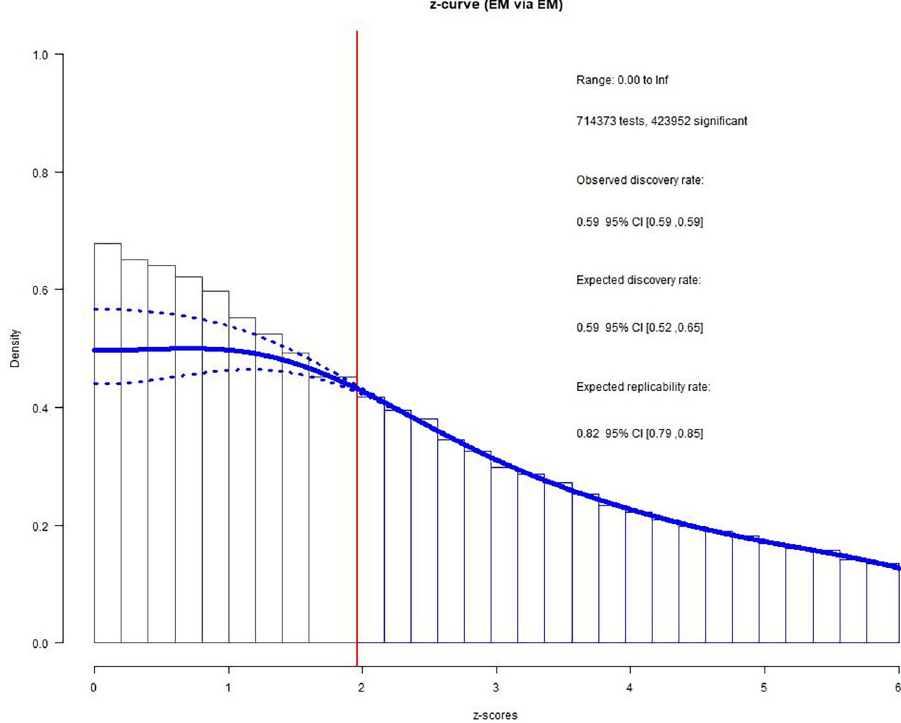
Fig 3. Z-curve results for the substantive dataset.